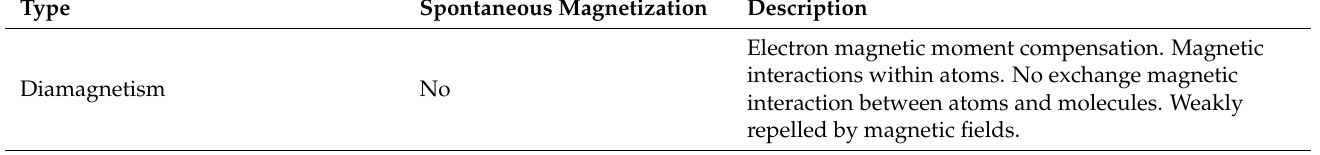
Table 1. Types of magnetic materials and their response to the external magnetic field.